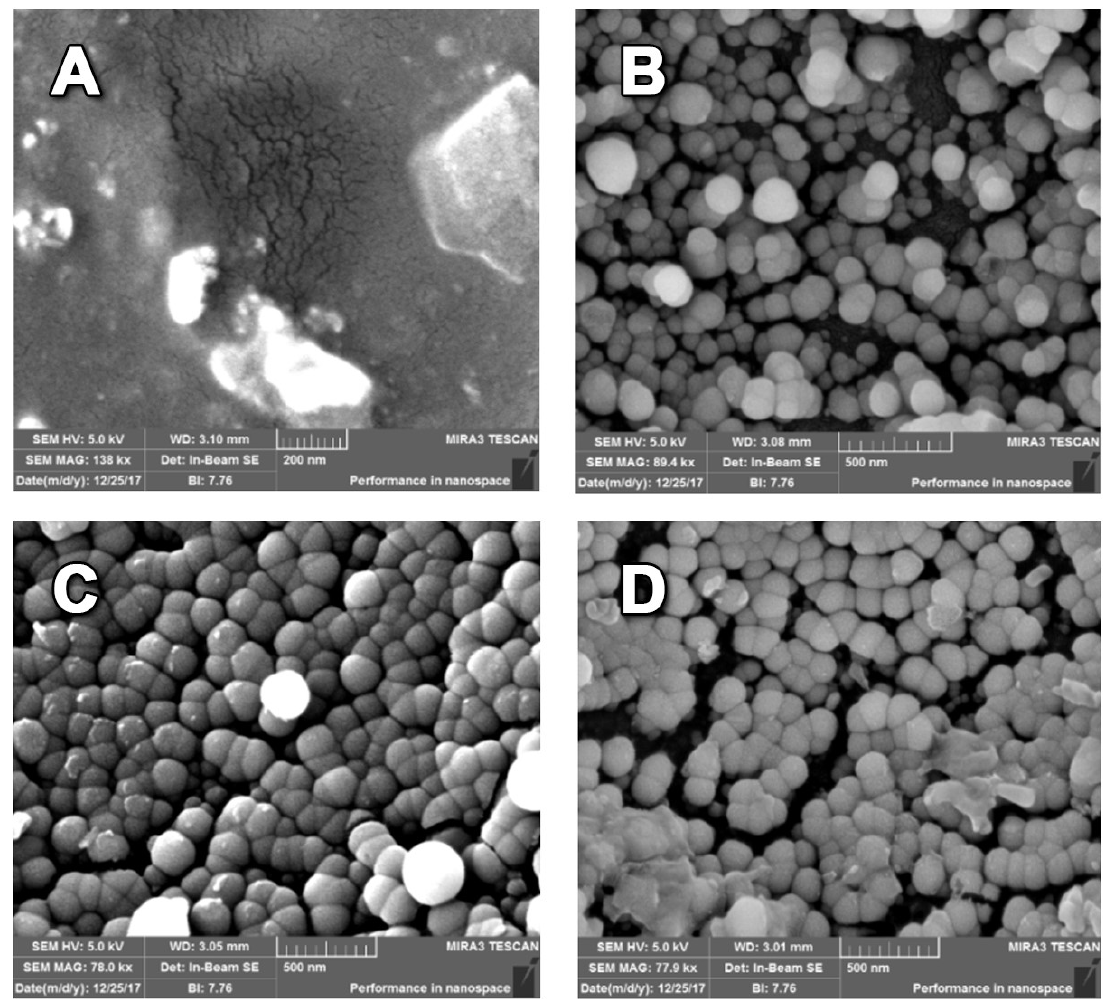
Figure 4. High resolution scanning electron microscopy (HR-SEM) images of ( A ) PVA, ( B ) PVA-SNP, ( C ) PVA-SNP-cur and ( D ) PVA-SNP-ba